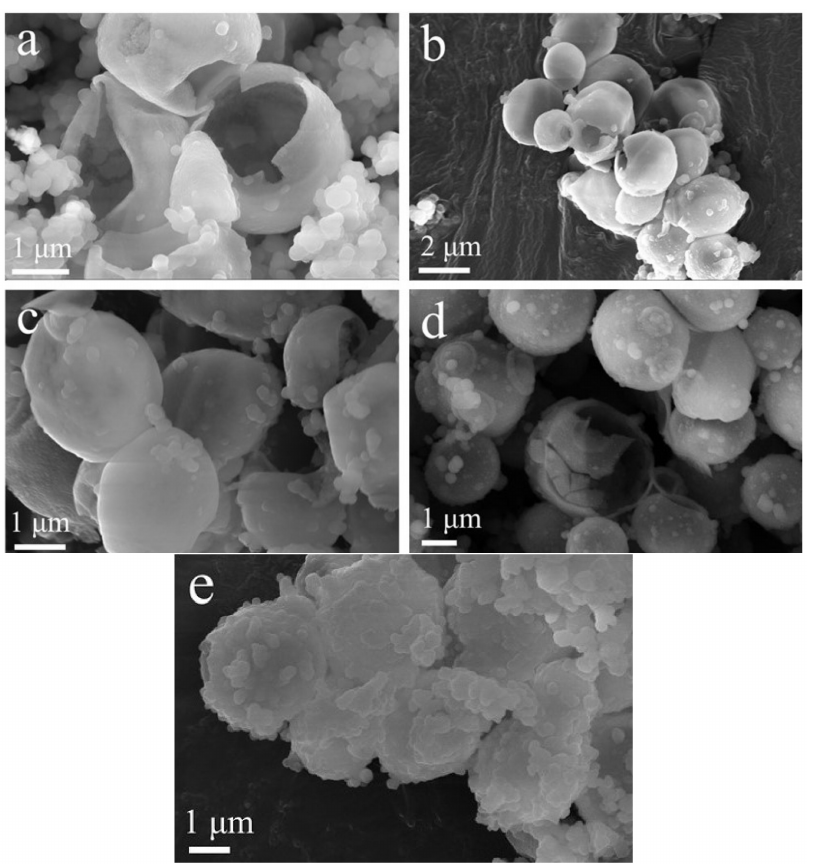
Figure 2. SEM images of SiO 2 synthesized at different TEOS concentrations: ( a ) 0.9 mol/L;